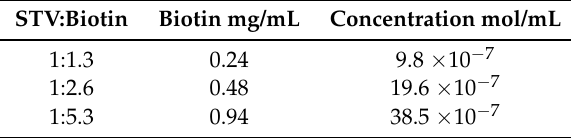
Table A2. Biotin concentrations corresponding to the molar streptavidin:biotin ratios. Streptavidin